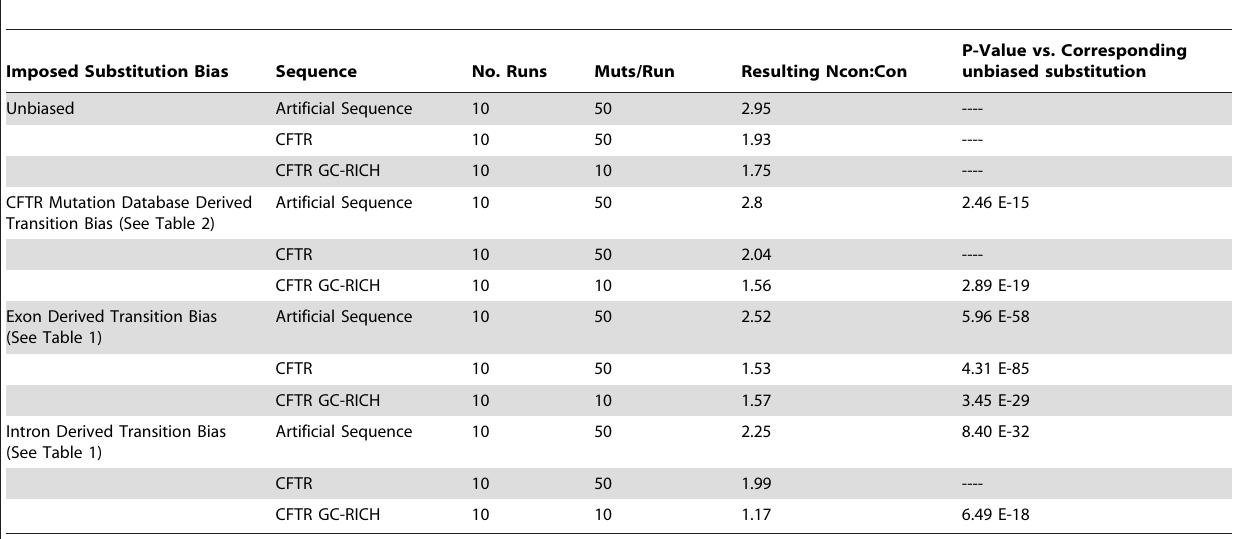
Table 5. Computer Simulation of SNP Accrual in the Setting of a Transition Bias Leads to Enhancement of Conservative Mutations.